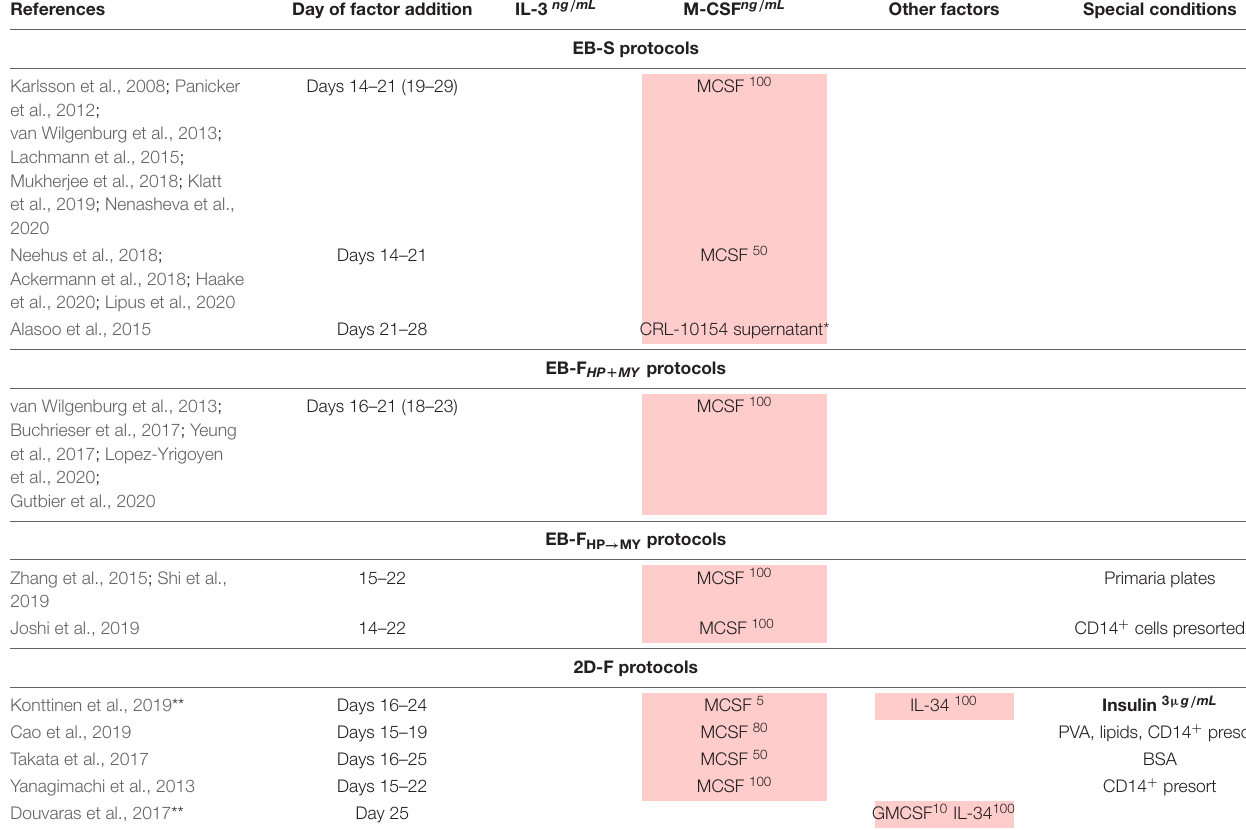
Color clues: pink, MF stage. *MCSF-producing cell line. **Microglia differentiation